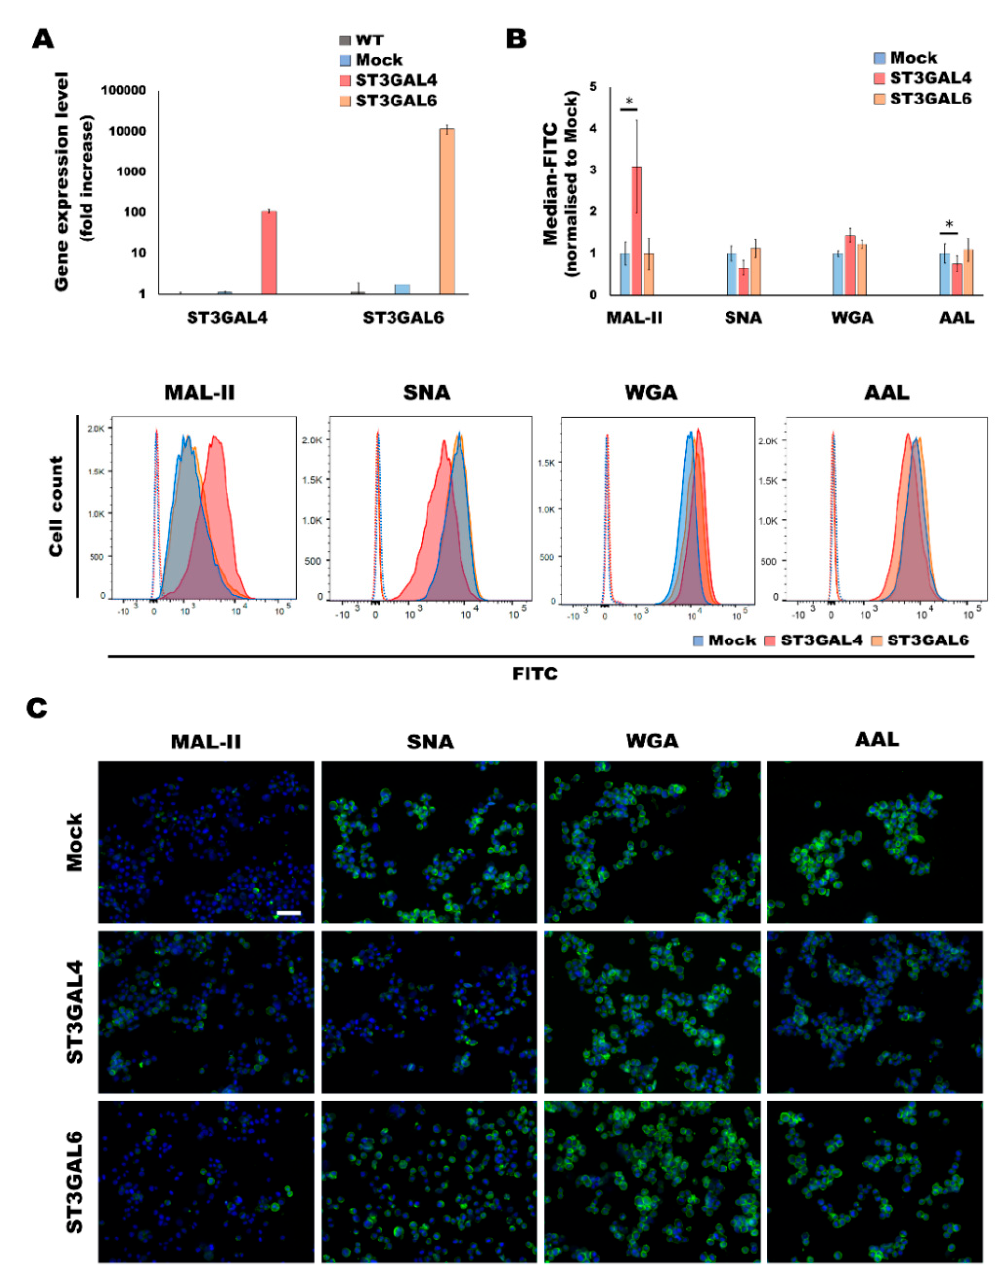
Figure 1. Characterization of the α 2,3-overexpressing cancer cell models. ( A ) Expression analysis of the ST3GAL4 and ST3GAL6 mRNA levels of the glycoengineered cell lines and the corresponding control cell lines, wild type (WT) and mock (containing the empty vector) by qRT-PCR. Data represents the average ±SD of 3 technical replicates. ( B ) Flow cytometry analysis of a panel of lectins in MKN45 glycoengineered cell lines as compared to the mock cell line. For each lectin, at least 2 independent experiments were performed. A representative plot for each lectin is also depicted. The negative controls are shown in dotted lines. Statistical significance was determined by student’s t -test ( p -value < 0.05 was considered significant, indicated as *). ( C ) Lectin fluorescent staining of a panel of lectins for sialylation and fucosylation characterization of the gastric cancer cell lines. The cytometry graphs and the immunofluorescence images are representative results of at least 2 independent replicates. Scale bar represents 50 μ m.